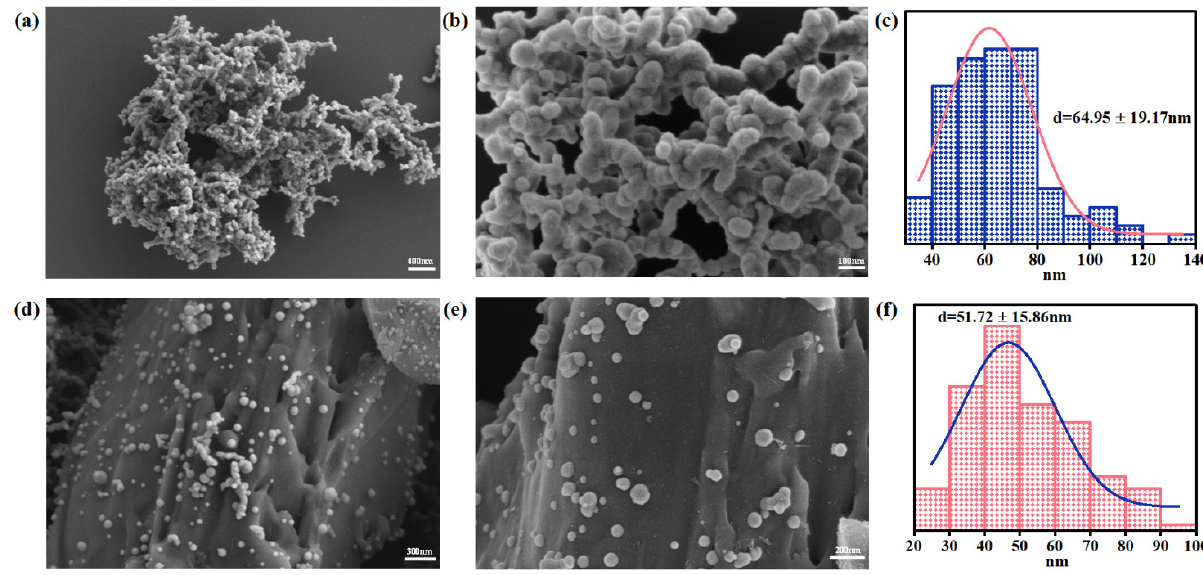
Figure 2. SEM images and corresponding particle size distribution of nZVI ( a – c ) and RBC600-nZVI ( d – f ). The insertion: the nanoparticle size distribution, calculated with Nano Measurer and 100 particles were selected for each sample.